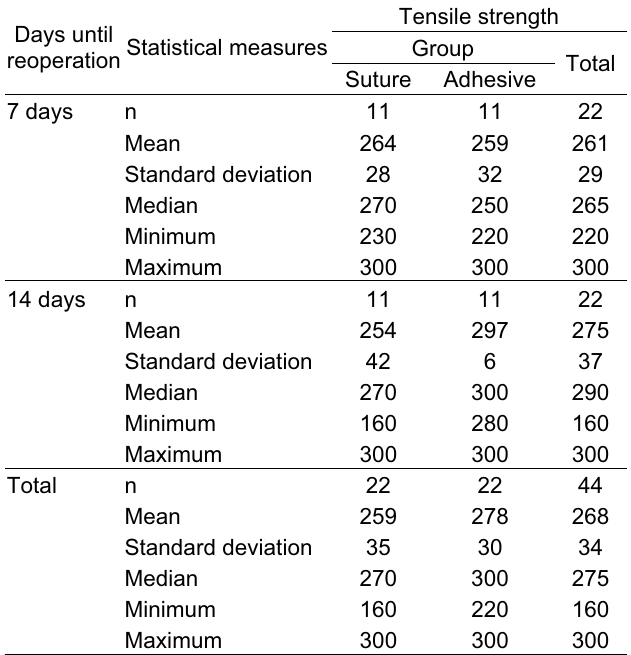
TABLE 7 – Tensile strength values (mm Hg)